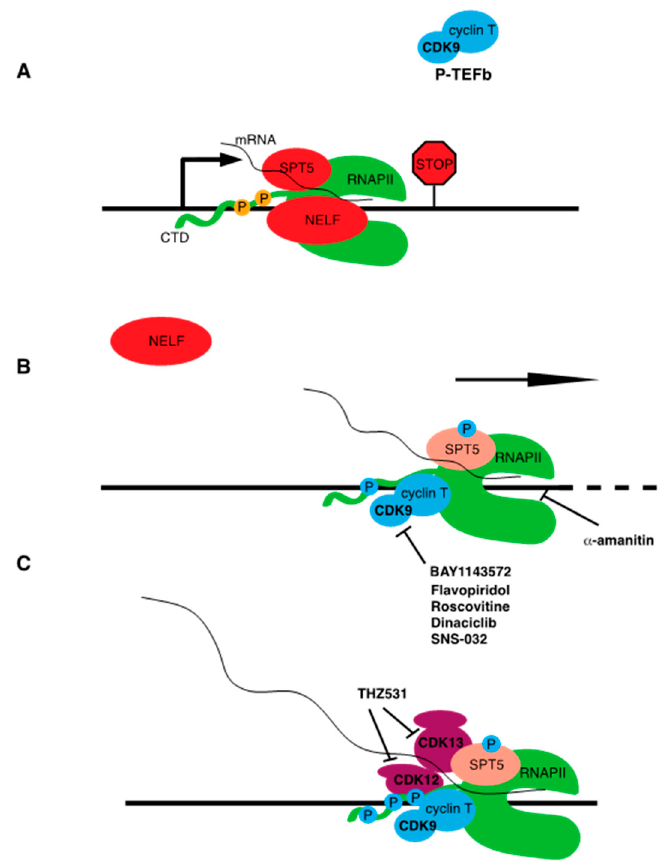
Figure 3. Inhibition of RNAPII transcription elongation. ( A ) Promoter-proximal pausing of RNAPII is enforced by SPT5 and the NELF complex. ( B ) P-TEFb engages the paused polymerase and phosphorylates SPT5 (blue circle), the RPB1 CTD (on multiple sites including serine 2, shown as blue circle), and NELF-E, leading to NELF dissociation and pause release. Inhibitors of CDK9 discussed in the text are indicated. Elongation of the nascent mRNA chain is inhibited by α -amanitin. ( C ) CDK12 and CDK13 promote CTD serine 2 phosphorylation, mRNA processing, and elongation.